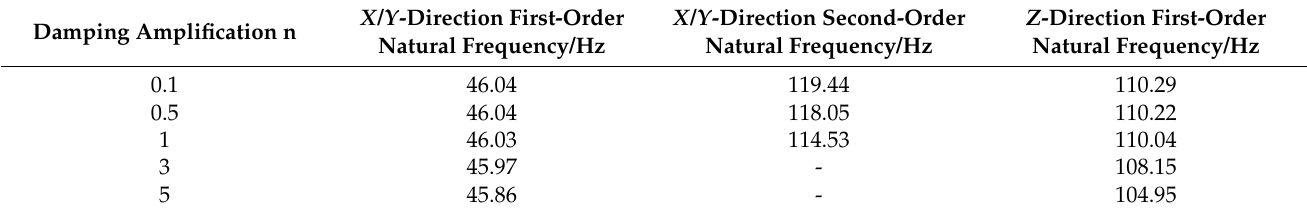
Table 5. Theoretical natural frequencies of Stewart platform with different magnification damping.